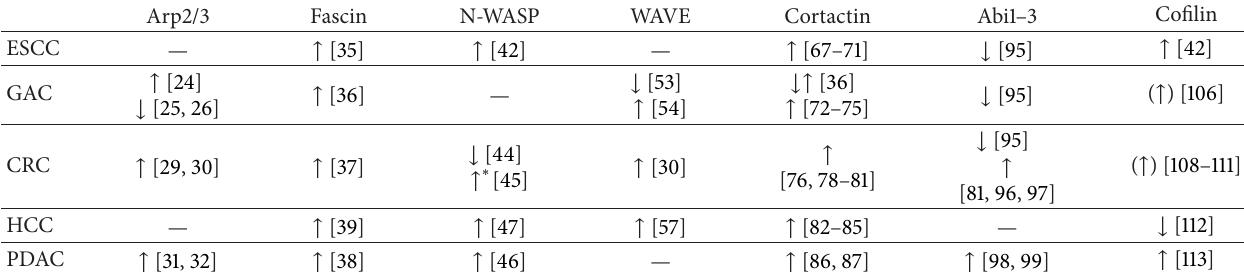
Table 1: Expression patterns of actin-binding proteins in gastrointestinal tract tumors. Arp2/3 Fascin N-WASP